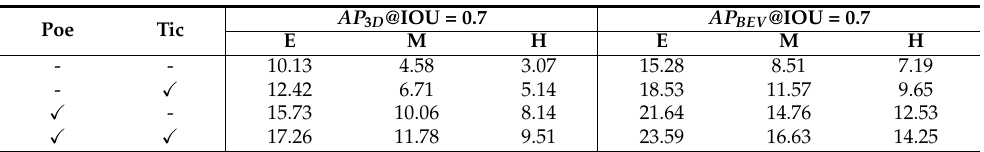
Table 5. Evaluation for the influences of position encoding (Poe) and timing coefficient (Tic) settings: E, M, and H indicate the levels from Easy, Moderate, to